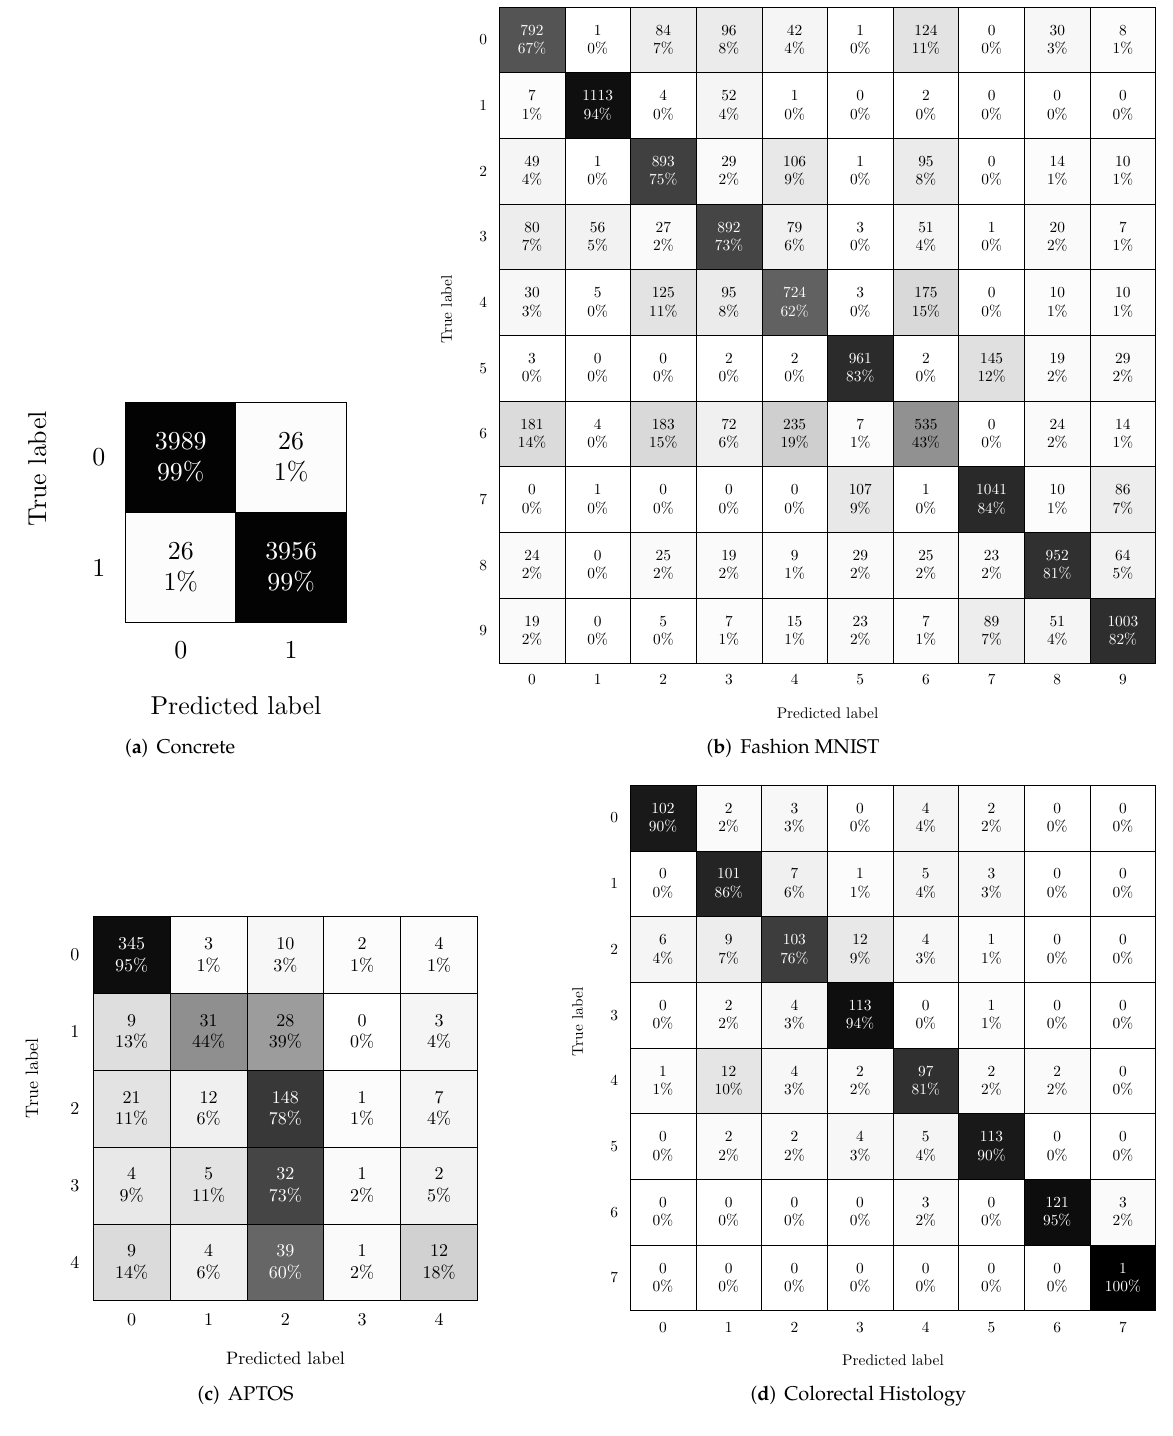
Figure 14. Confusion matrices of implementation with ResNet 1D. ( a ) Concrete, ( b ) Fashion MNIST, ( c ) APTOS, ( d ) Colorectal